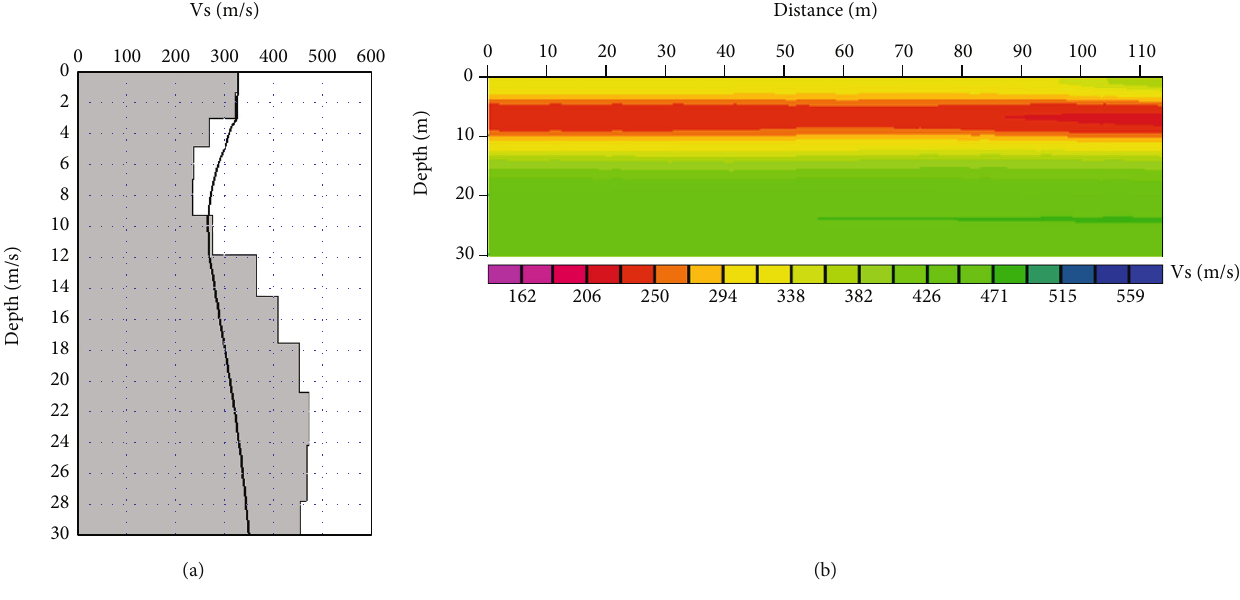
Figure 9: (a) MASW 2 1D pro fi le and (b) 2D Vs